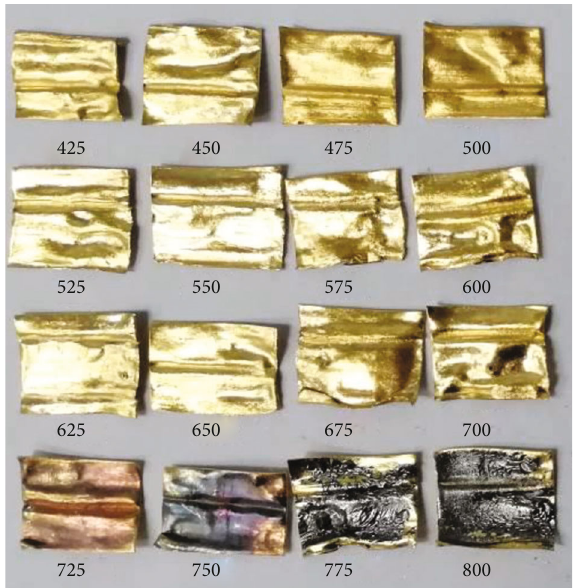
Figure 4: Inner wall photo of a tube heated to di ff erent